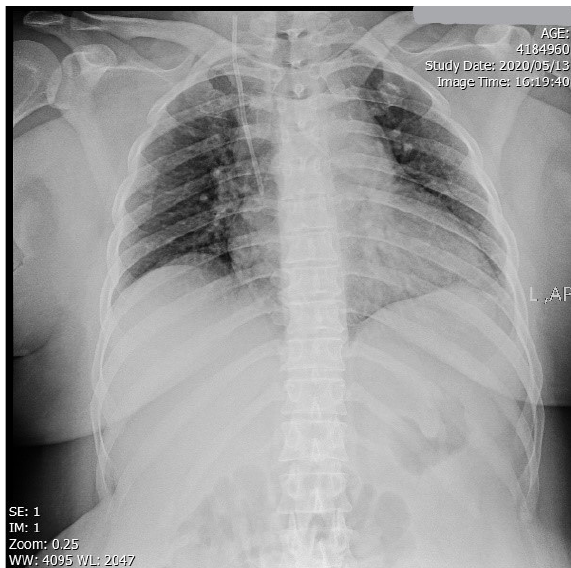
Figure 1. Conventional X-ray Showing the Residual Catheter in the Right Internal Jugular Vein and Superior Vena Cava.